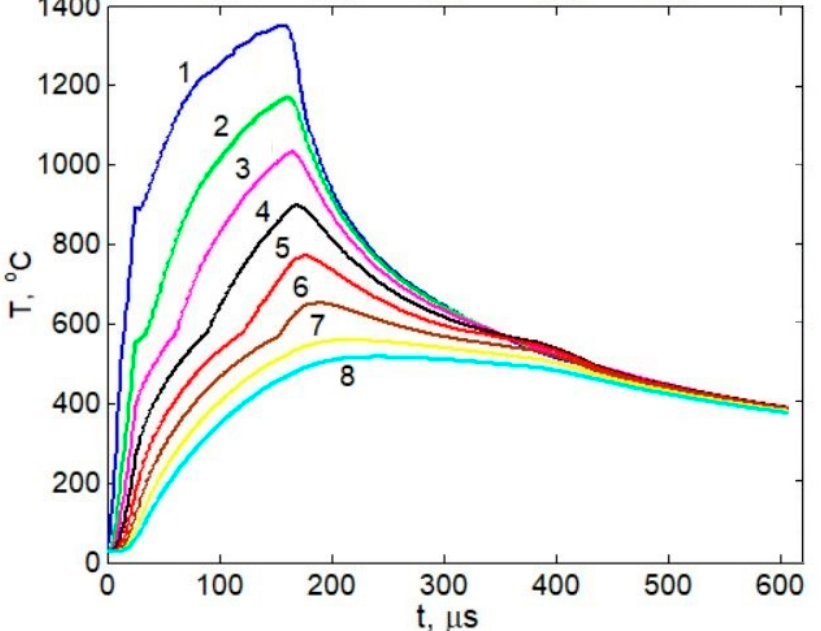
Figure 10. Time variations of the temperature at different depths of the silumin sample with a 1- µ m coating: depth = 0 (curve 1), 10 (curve 2), 20 (curve 3), 30 (curve 4), 40 (curve 5), 50 (curve 6), 60 (curve 7), and 70 µ m (curve 8).